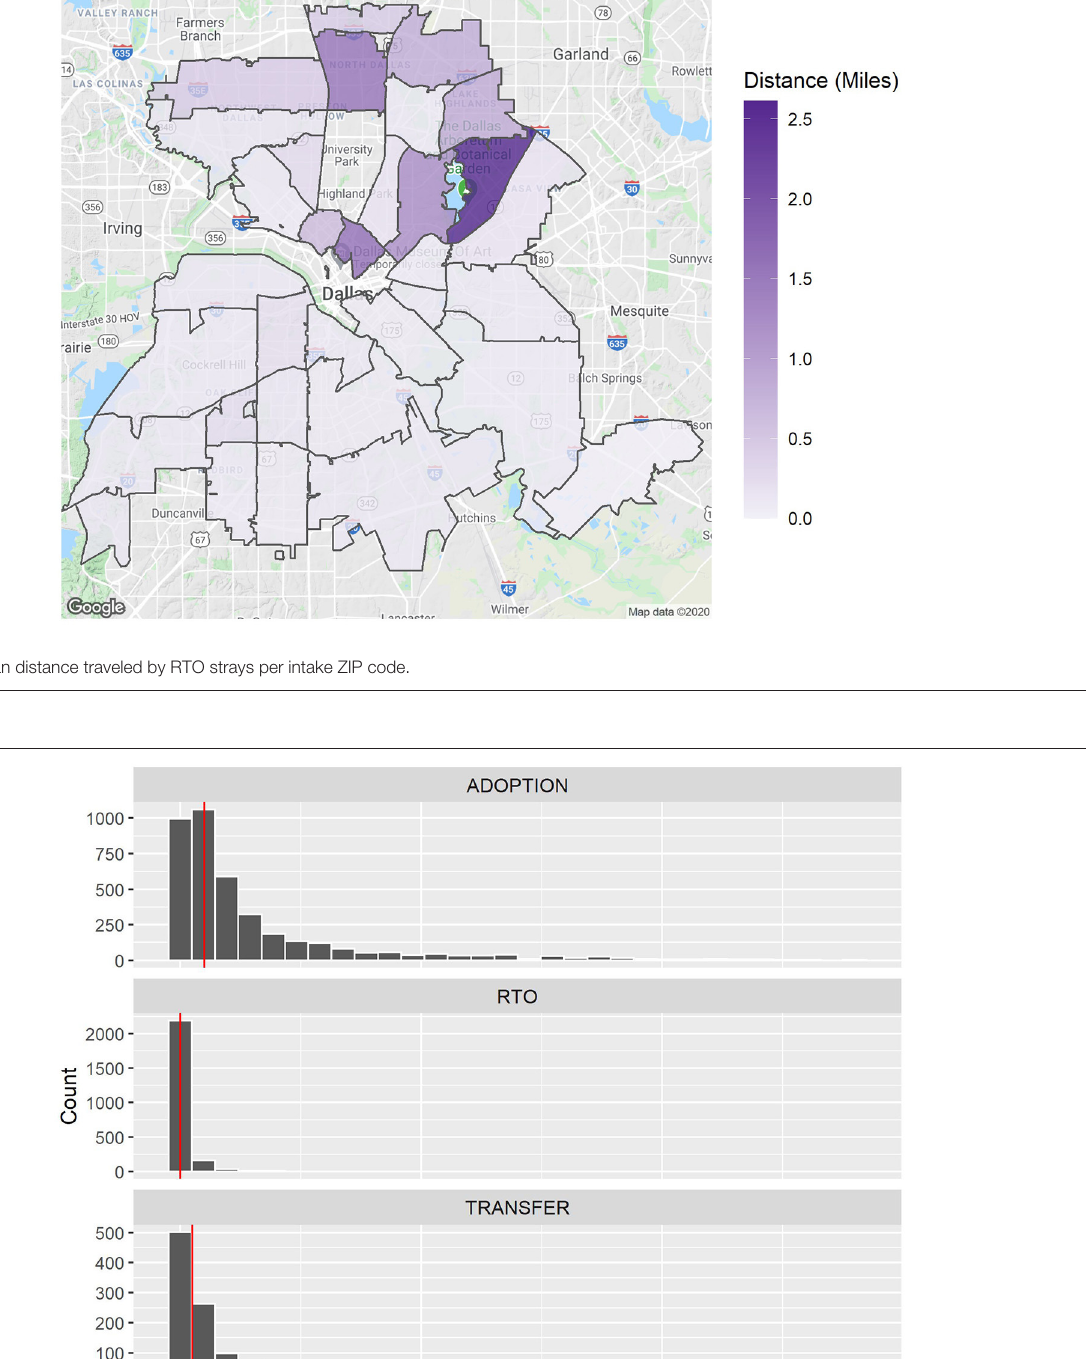
Frontiers in Veterinary Science |